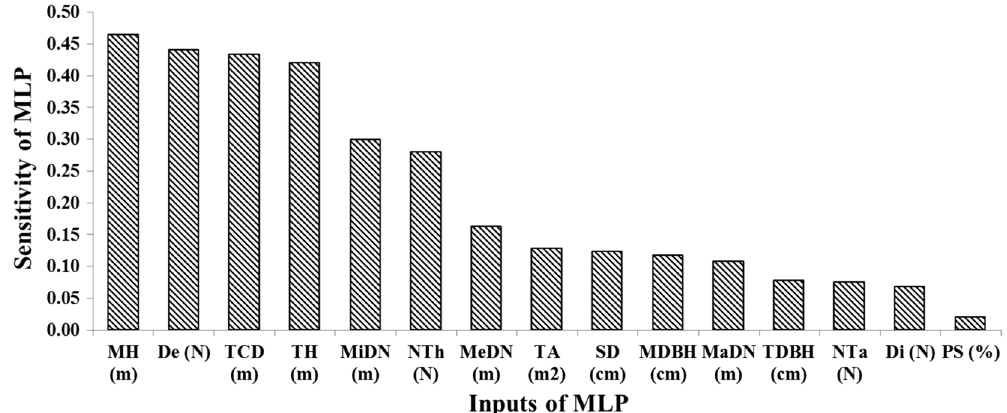
Figure 7. The impact value (0 to 1) of input variables on the tree failure model outputs in sensitivity analysis of model (trees Mean Height (MH), trees Density (De), Tree Crown Diameter (TCD), Tree Height (TH), Minimum Distance from Neighbor trees (MiDN), Number of Thicker trees (than the target tree) (NTh), Mean Distance from Neighbor trees (MeDN), Tree Area (TA), Soil Depth (SD), trees Mean Diameter at the Breast Height (MDBH), Maximum Distance from Neighbor trees (MaDN), Tree Diameter at the Breast Height (TDBH), Number of Taller trees (NTa), trees Diversity (Di) and Plot Slope